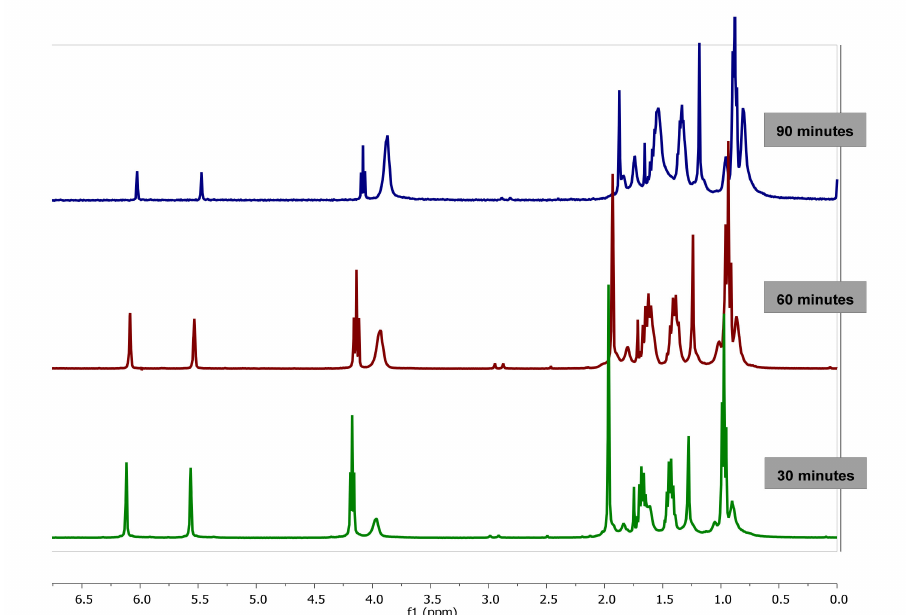
Figure 5. 1 H-NMR spectra of PBMA obtained by polymerization in confinement (nanoreactor diameter of 60 nm) at 60 ◦ C, at different reaction time, using CDCl 3 -d.